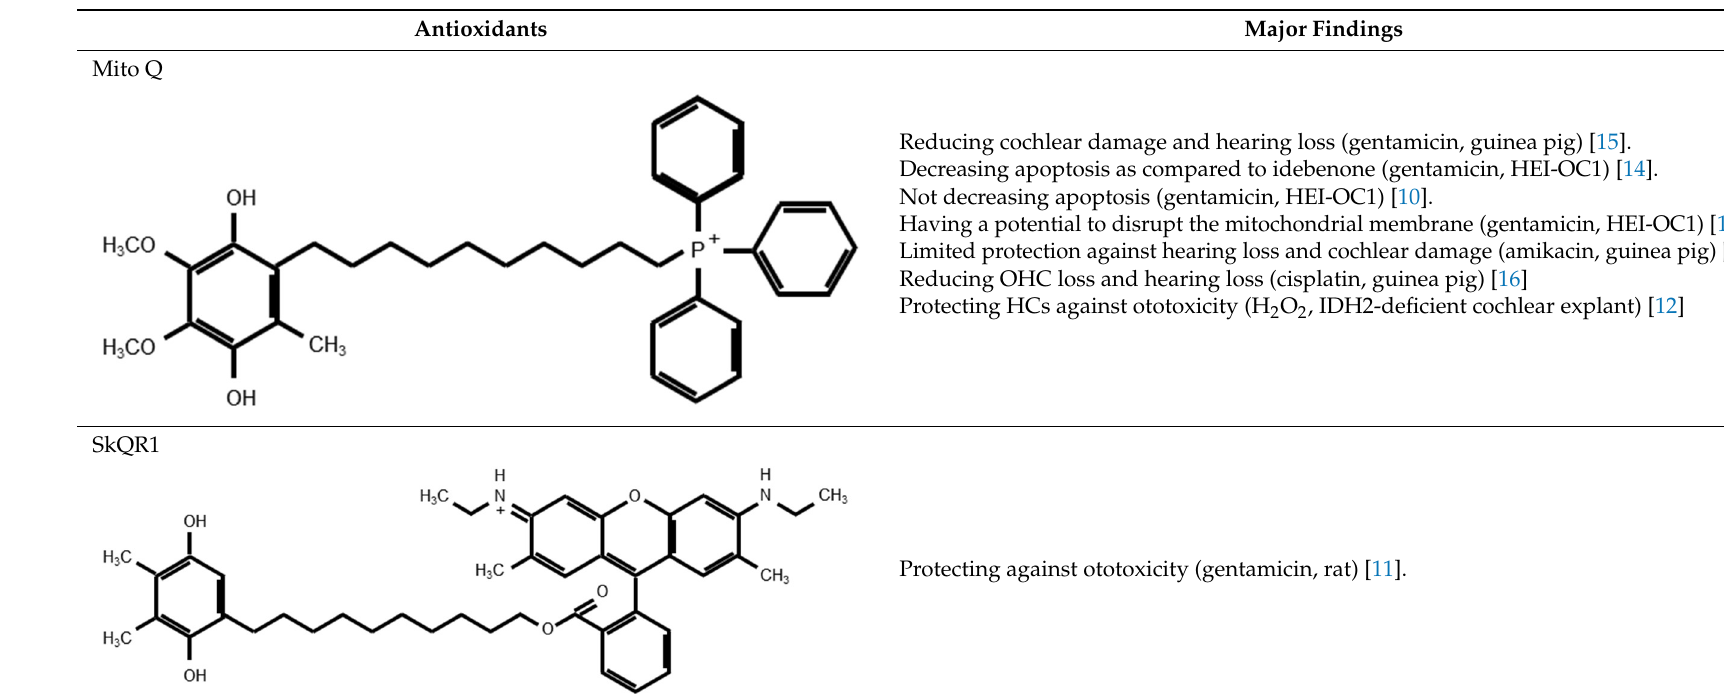
Table 1. Summary of major findings in the effect of mitochondria-targeted antioxidants on SNHL.